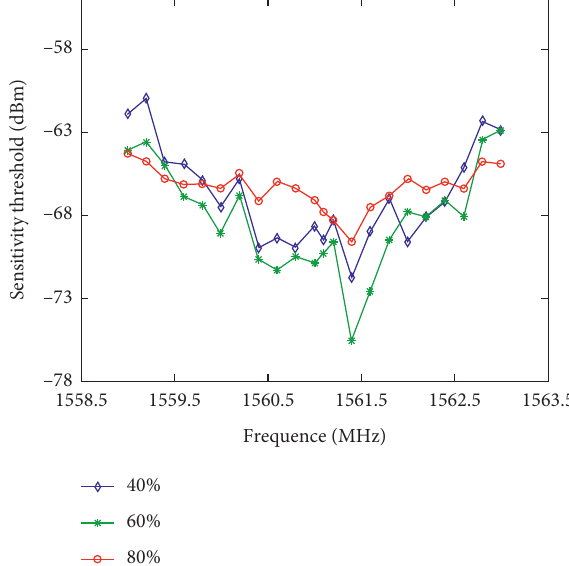
Figure 9: The electromagnetic sensitivity curve of the receiver when f PRF � 60Hz.